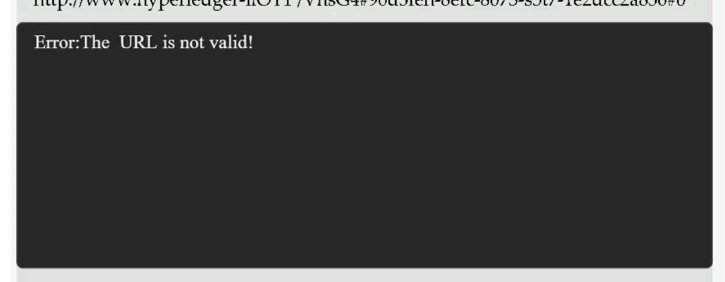
Figure 20. One-time URL information